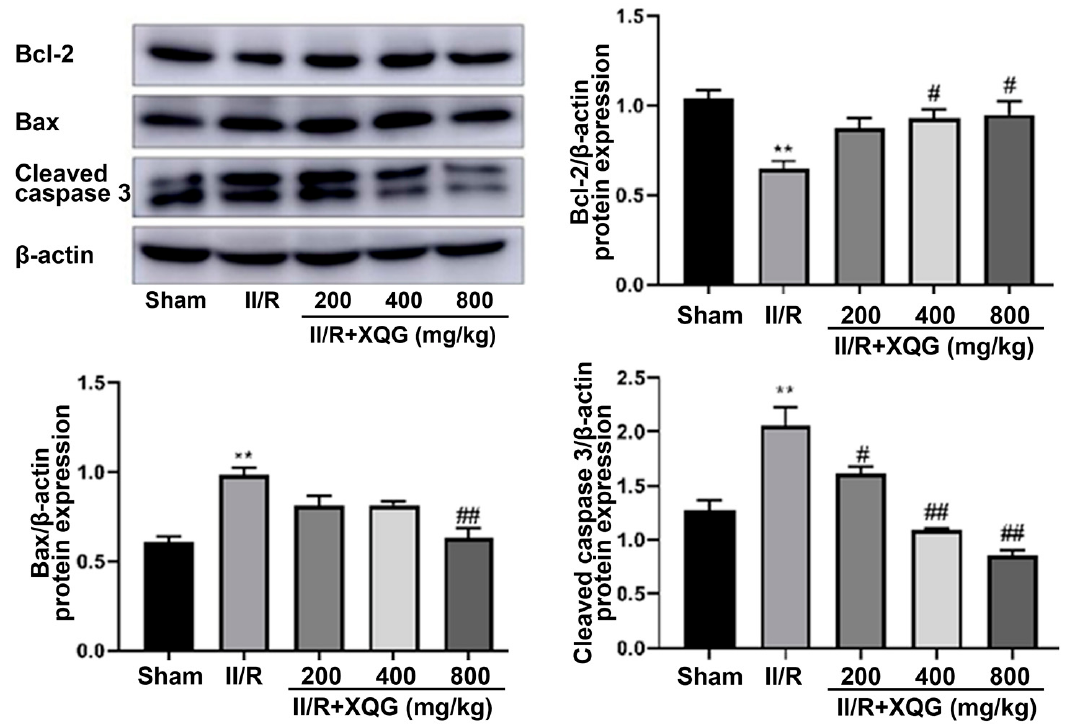
Figure 5. XQG alleviated II/R-induced apoptosis. Western Blot analysis of intestinal bcl-2, Bax, and cleaved caspase3. All values were expressed as mean ± SEM ( n ≥ 3). ** p < 0.01 vs. sham group, # p < 0.05 and ## p < 0.01 vs. II/R group.